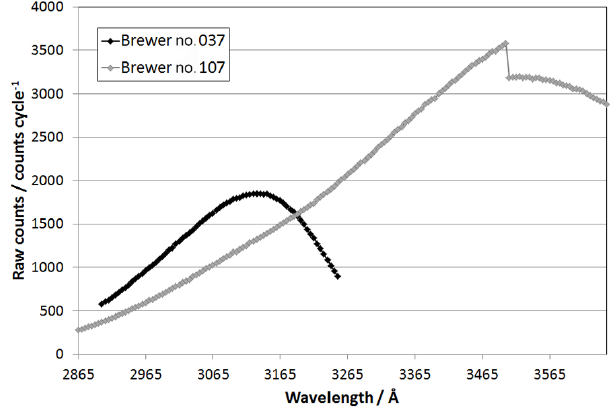
Figure 1. Typical spectral irradiance measurements of a 1000W standard lamp as raw counts per cycle. Brewer #037 measure- ment taken with primary standard lamp D24 on 20 March 2012. Brewer #107 measurement taken with primary standard lamp D01 on 26 January 2012.